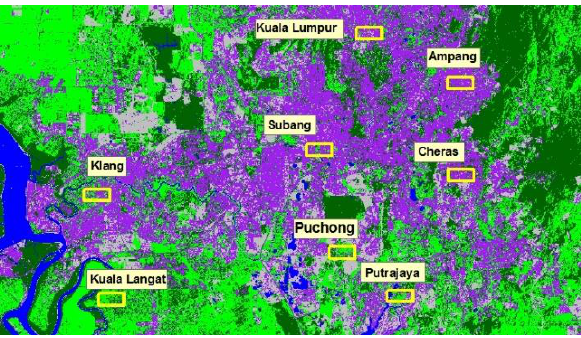
Figure 1. The randomly sampled areas